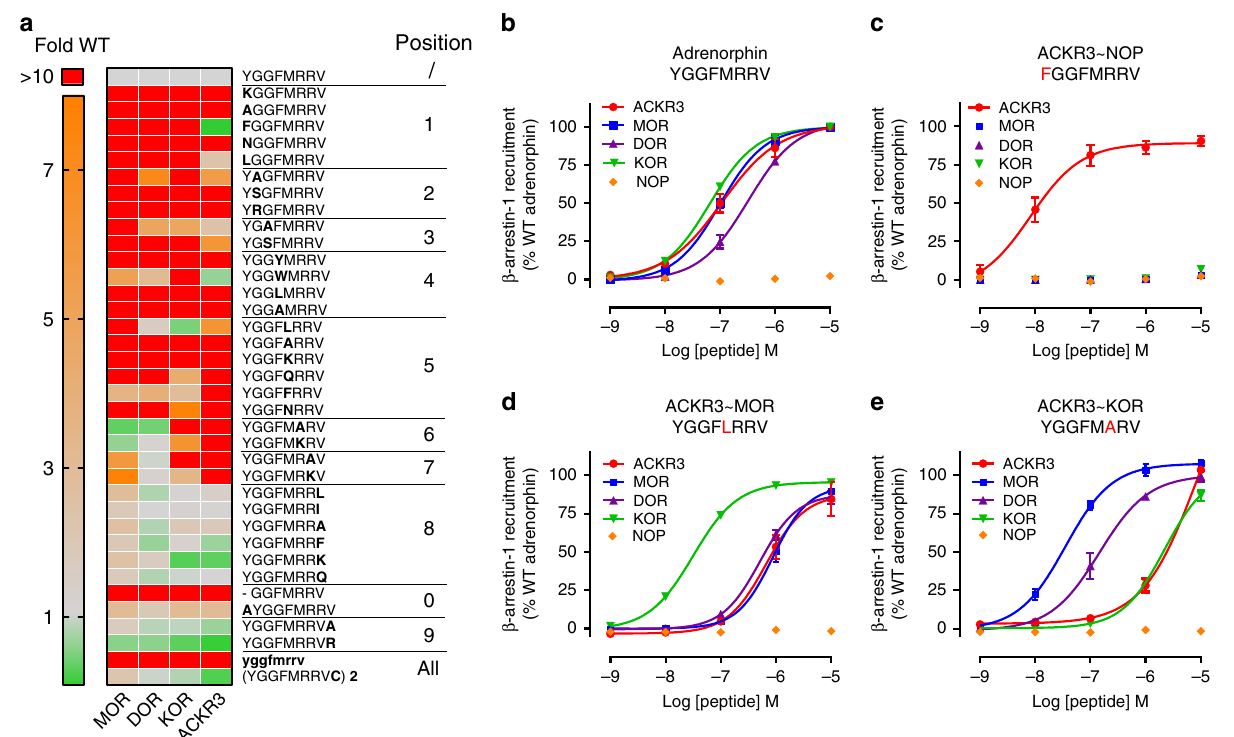
Fig. 3 SAR analysis of adrenorphin variants on ACKR3 and classical opioid receptors. a Comparison of the impact of substitutions, truncations, extensions, D-amino acid replacement or dimerization on the agonist activity of adrenorphin towards ACKR3, MOR, DOR, and KOR. The agonist activity of each variant was evaluated in β -arrestin-1 recruitment assay in U87 cells and expressed as fold change over the activity of wild-type adrenorphin. None of the peptides showed agonist activity towards NOP. b – e Comparison of potency and ef fi cacy of adrenorphin ( b ) and its variants bearing mutations Y1F ( c ), M5L ( d ) and R6A ( e ) to induce β -arrestin-1 recruitment to ACKR3 and the opioid receptors KOR, MOR, DOR and NOP in U87 cells. ∼ indicates a similar impact of the modi fi cation on the potency of the peptide towards ACKR3 and the indicated opioid receptor. Results represent the mean ( a ) or mean ± S.E. M ( b – e ) of three independent experiments ( n = 3). Corresponding EC 50 values are available in Supplementary Table 4. Source data are provided as a Source Data fi